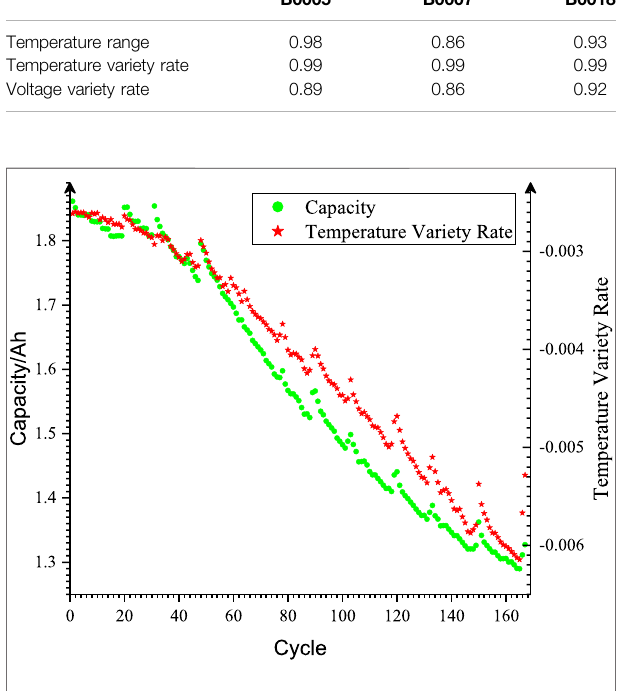
FIGURE 2 | Correlation between temperature variety rate and